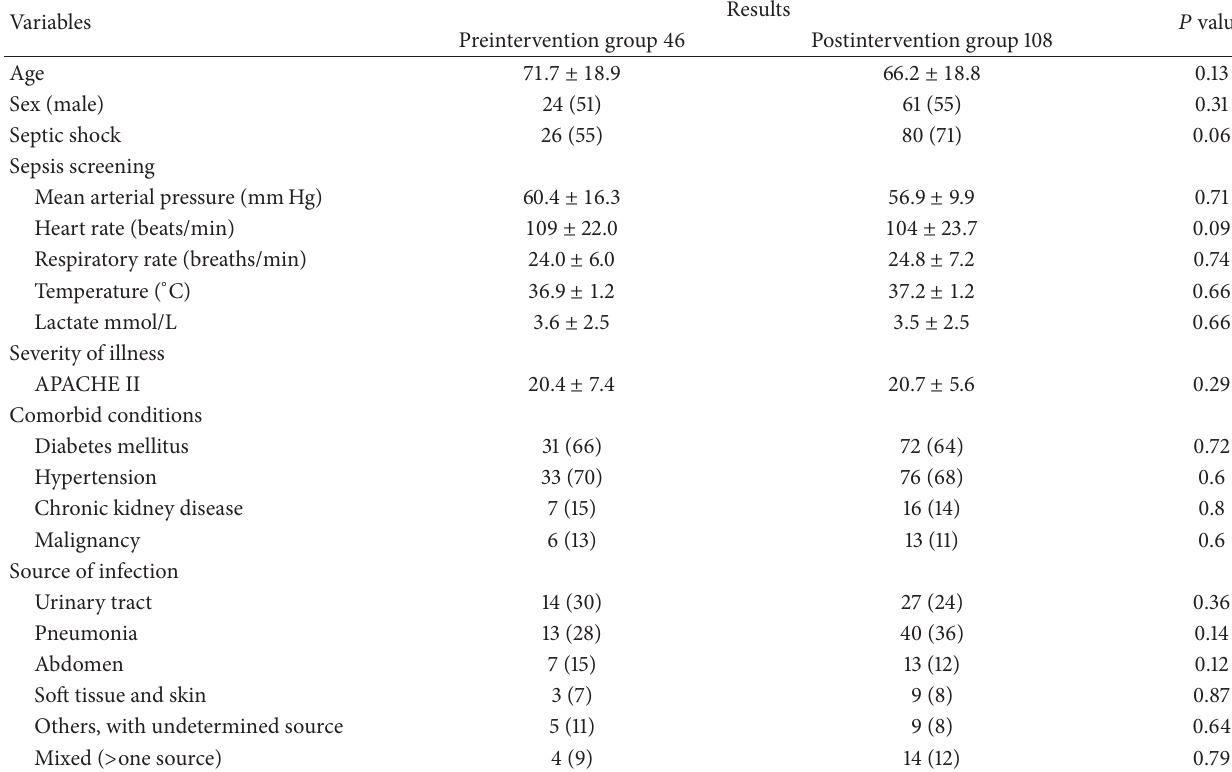
Table 2: Patients characteristics and clinical data.